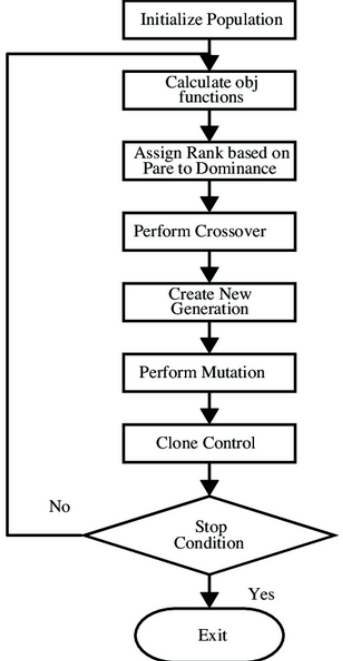
Figure 3. Flow chart of the genetic algorithm (GA) [33]. Table 1. Iteration and swarm size used in the optimization algorithm.